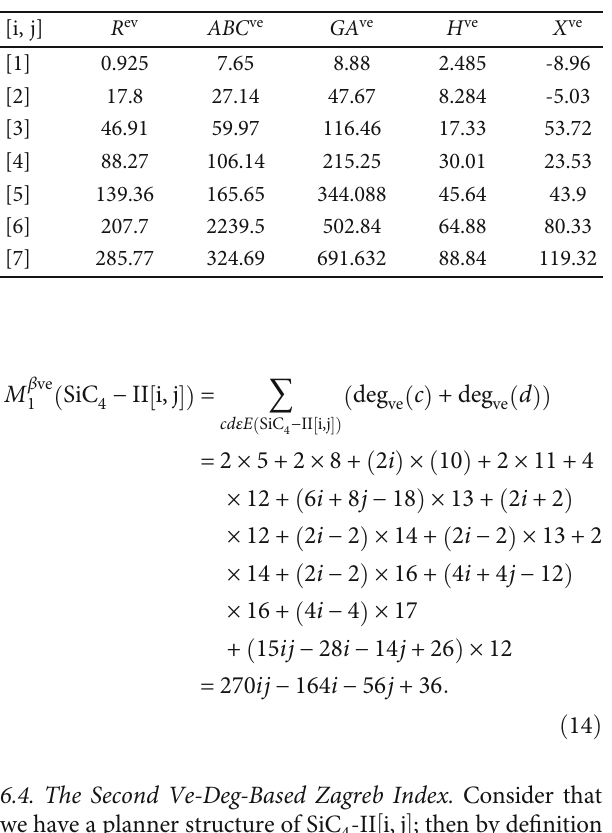
Table 9: Numerical calculations for silicon carbide SiC